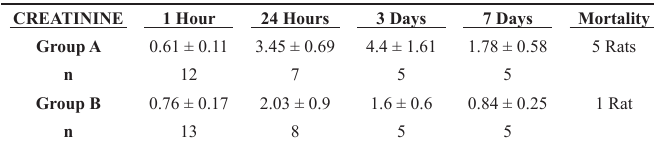
TABLE 2 - Mean ± SEM serum creatinine levels (mg%) of animals submitted to warm renal ischemia for one hour followed by contralateral nephrectomy, pretreated or not with lovastatin at the dose of 15 mg/kg/day for ten